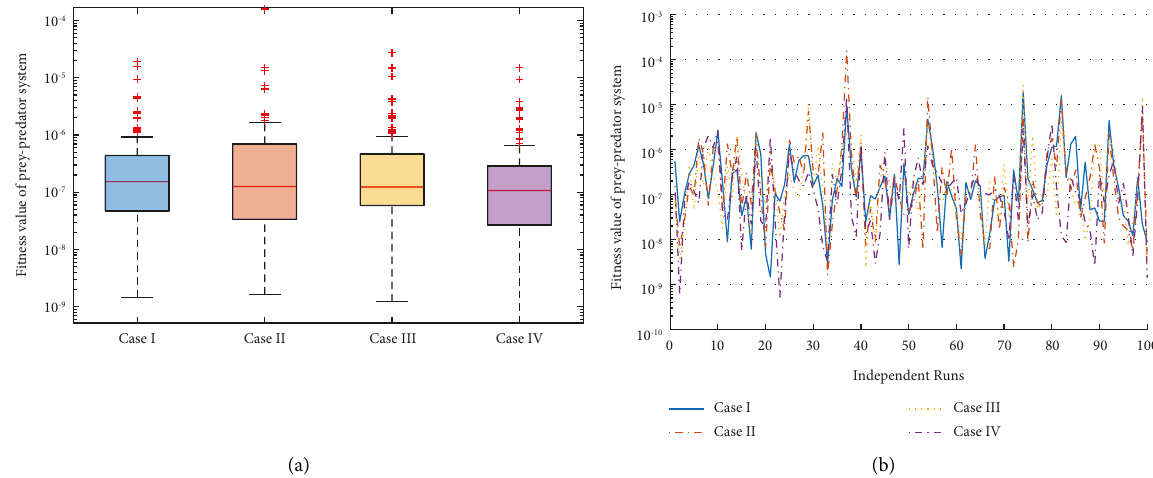
Figure 17: Comparison between the box plots and the convergence graph of fitness evaluation over 100 independent runs for the prey- predator model with variations in the catching rate of local prey. (a) Box plots for fitness evaluation of the prey-predator model with variations in c . (b) Convergence of the fitness value of the prey-predator model with variations in c 1